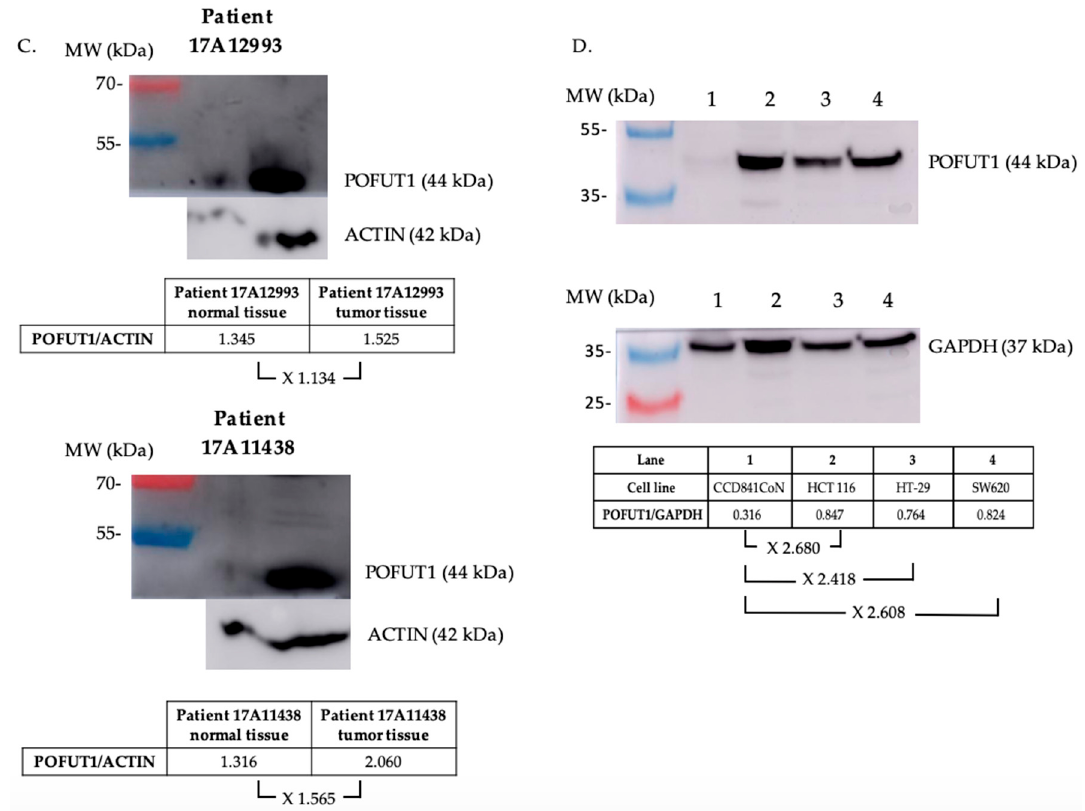
Figure 2. POFUT1 expression in colorectal tissues and cell lines. Immunohistochemistry analysis ( A ) shows that POFUT1 is overexpressed in tumor tissues from first colorectal cancer (CRC) stage. Immunofluorescence labeling of POFUT1 (red), performed on wild-type and POFUT1 knockdown HCT 116 and SW620 human colorectal cancer cell lines, confirmed the antibody specificity ( B ). Western blot realized on colorectal tissues ( C ) and colorectal CCD841CoN, HCT 116, HT-29 and SW620 cell lines ( D ) validate the POFUT1 overexpression in cancer samples compared to healthy samples.